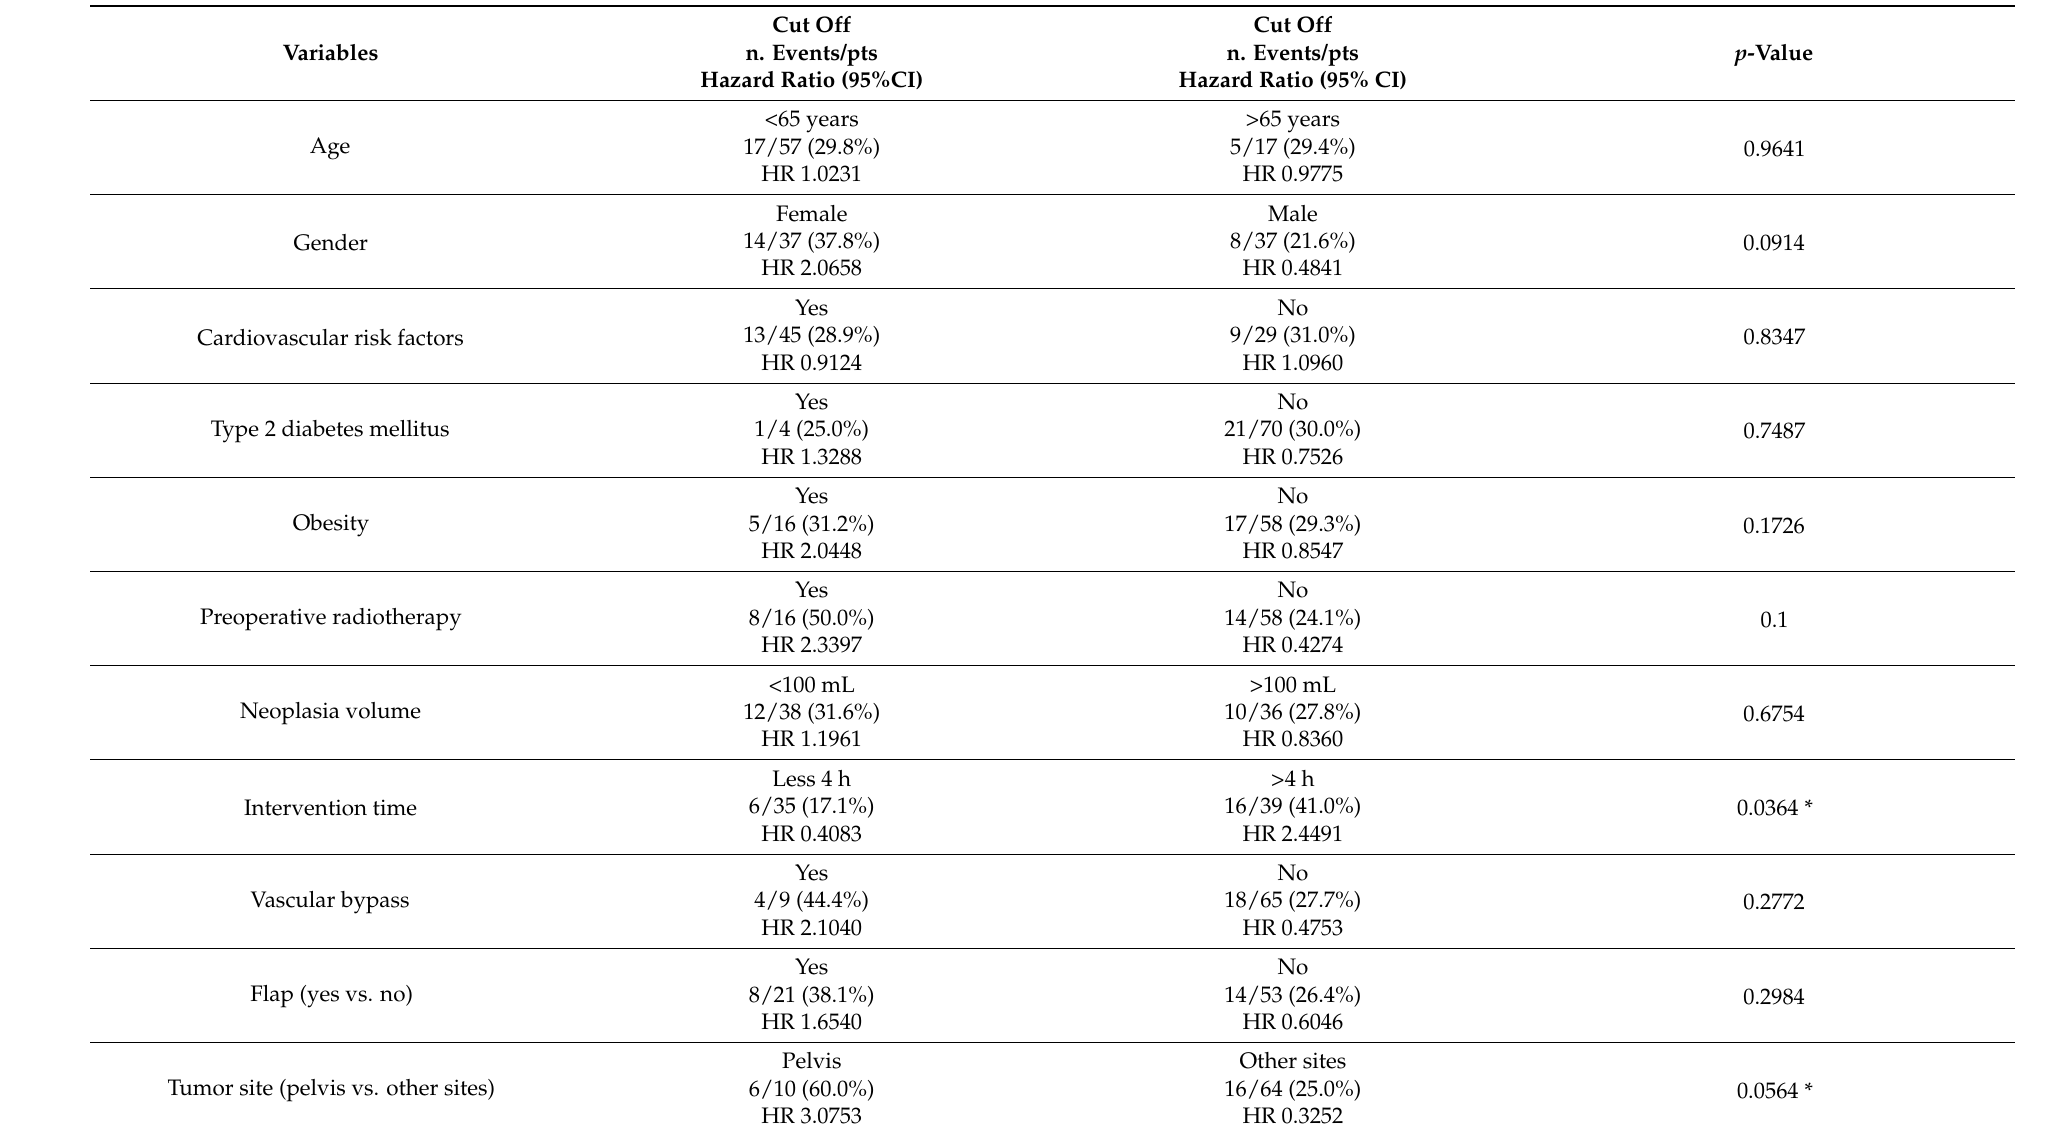
Table 3. Risk factors for major complications (Grade III Clavien–Dindo) of ortho-vascular surgery in the patients included in this series.